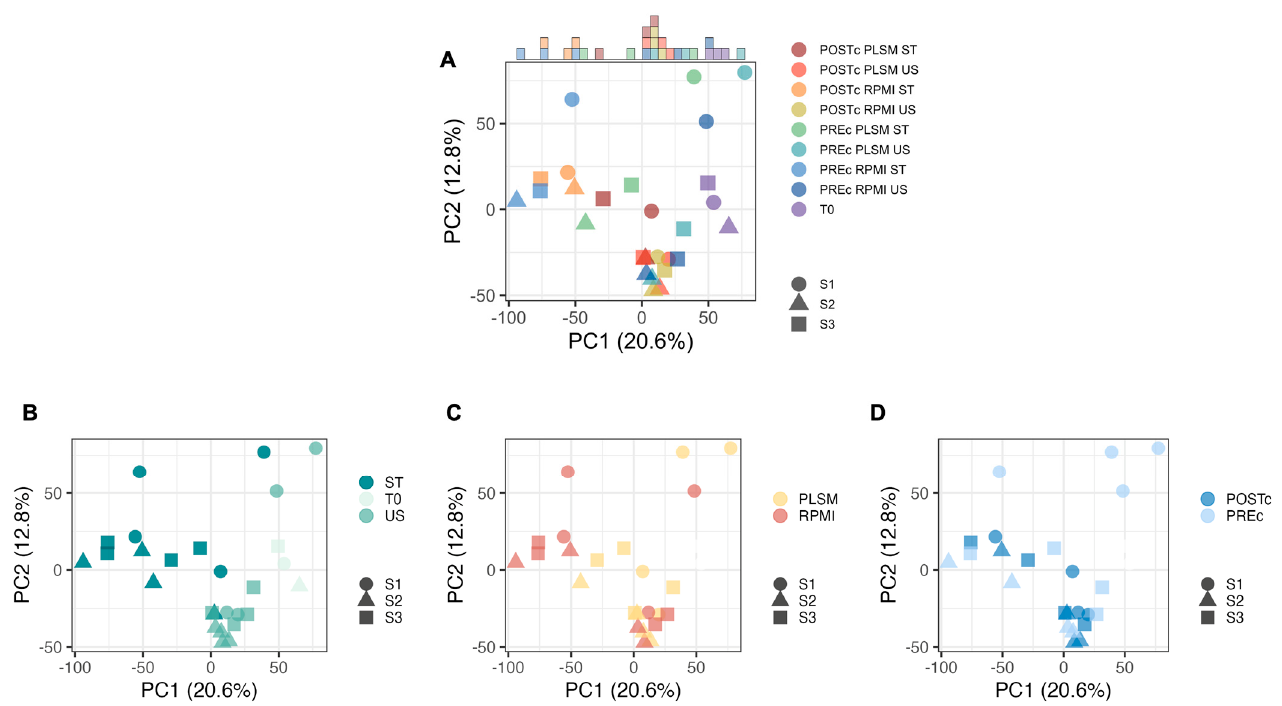
Figure 2. Overview of the transcriptomic profiles of the 3 study participants (S1, S2, and S3) in the 9 experimental settings analyzed through Principal Component Analysis (PCA). Rectangles on the top indicate the frequency of each experimental setting along the x -axis (PC1). ( A ). To highlight the impact of single experimental conditions, the same PCA was colored according to stimulation ( B ), culture medium ( C ), and CD4 + T cells isolation strategy ( D ).